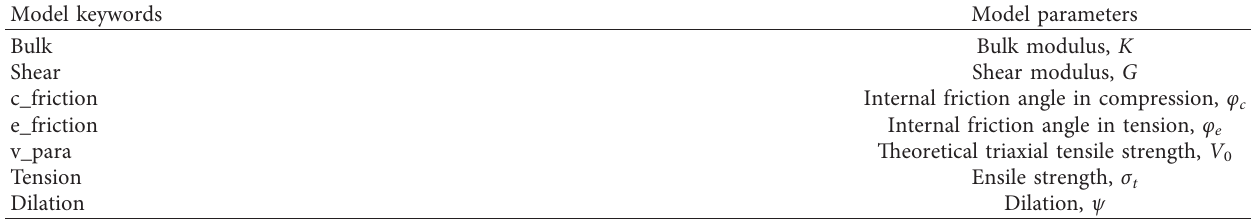
Table 2: PMC model parameters and keywords corresponding table.